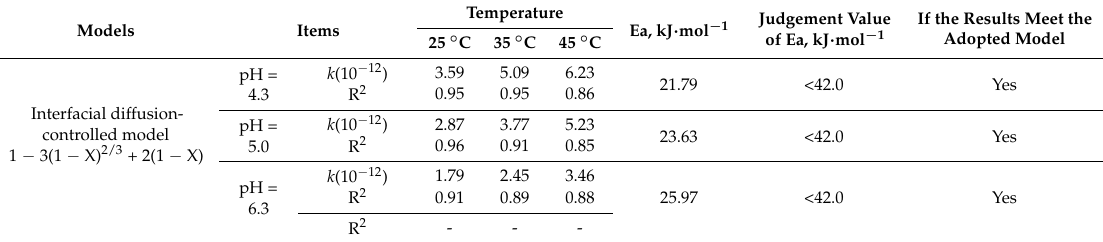
Table 5. Fitting constants and apparent activation energies by using interfacial diffusion-controlled model for montmorillonite a